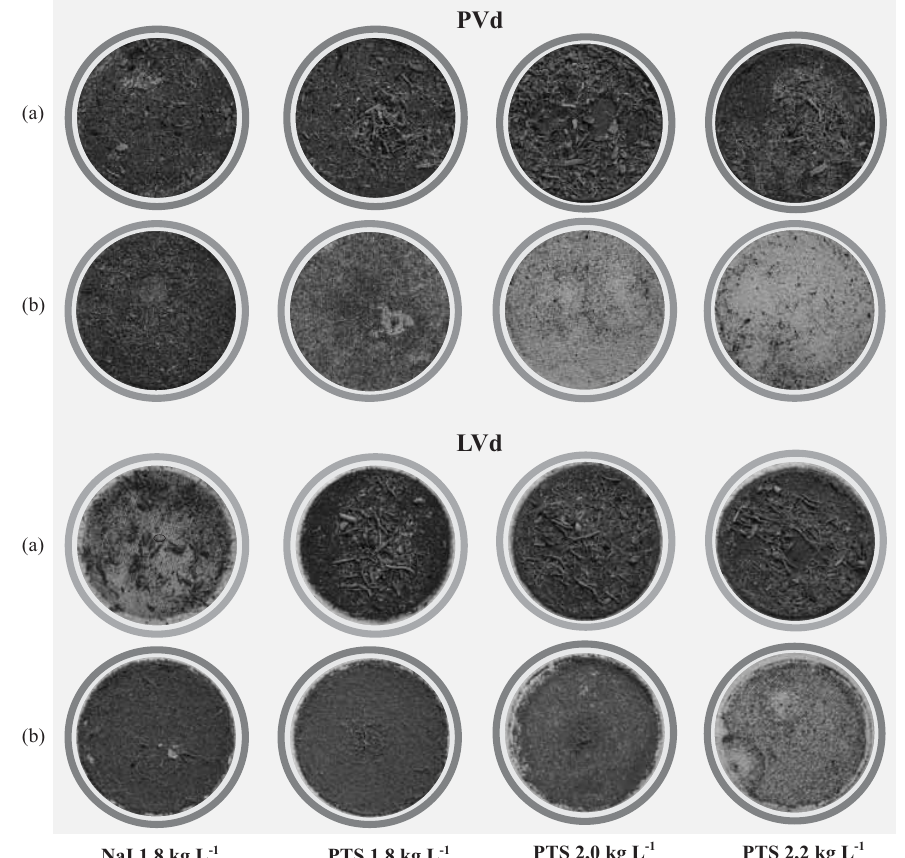
Figura 2. Visualização do aspecto dos filtros da fração leve (FL) (a) e da matéria orgânica particulada residual (b) utilizados no fracionamento densimétrico da matéria orgânica com soluções de iodeto de sódio (NaI) e de politungstato de sódio (PTS) na camada de 0–5 cm de um Argissolo Vermelho (PVd) e de um Latossolo Vermelho